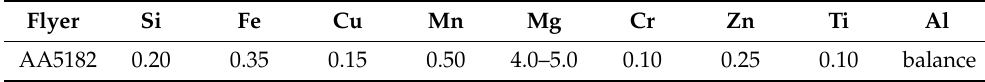
Table 1. Chemical composition (max. %at.) of AA5182 (flyer) [27]. Flyer